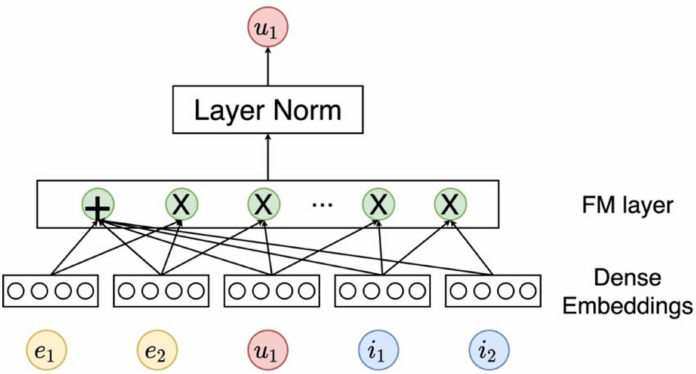
Figure 5. FM aggregator.